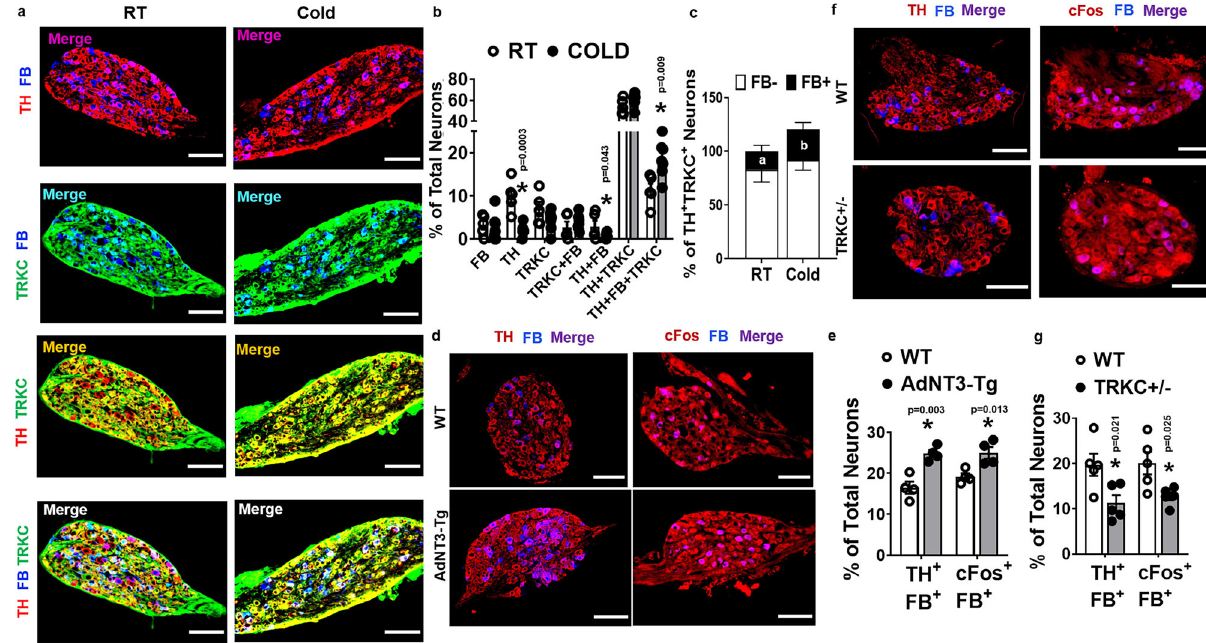
Fig. 6 NT-3/TRKC regulates sympathetic ganglia neuronal activity. a , b Representative images of TH, Fast Blue (FB) and TRKC-EYFP labeling ( a , from fi ve replicate animals for RT, and 7 replicate animals for cold, scale bar = 75 µ m), and percentage of single-, double-, and triple-labeled neurons ( b , RT = 5, cold = 7, * indicates statistical signi fi cance between RT and cold treatments with unpaired two-tailed t test) in sympathetic ganglia at thoracic T2 level in TRKC-Cre::R26EYFP mice at room temperature (RT) or subjected to a 7-day cold challenge. In panel b , the calculation of single-, double-, and triple-labeled neurons is mutually exclusive, i.e., the number of single-labeled neurons does not include double- or triple-labeled neuron numbers, and the number of double-labeled neurons does not include triple-labeled neuron numbers. c Percentage of FB-positive (FB + ) and FB-negative (FB - ) neurons in TH/TRKC- positive neurons in sympathetic ganglia at thoracic T2 level in TRKC-Cre::R26EYFP mice at room temperature (RT) or subjected to a 7-day cold challenge (RT = 5, COLD = 7, a vs b: FB + in RT vs FB + in cold, P = 0.010 with unpaired two-tailed t test). d , e Representative images ( d , from four replicate animals/ group, scale bar = 75 µ m) and quantitation ( e , n = 4/group, * indicates statistical signi fi cance between WT and AdNT3-Tg with unpaired two-tailed t test) of TH/FB and cFos/FB labeling in sympathetic ganglia at thoracic T2 level in WT and AdNT3-Tg mice after a 7-day cold challenge. f , g Representative images ( f , from fi ve replicate animals/group, scale bar = 75 µ m) and quantitation ( g , n = 5/group, * indicates statistical signi fi cance between WT and TRKC + / − with unpaired two-tailed t test) of TH/FB and cFos/FB labeling in sympathetic ganglia at thoracic T2 level in WT and TRKC + / − mice after a 7-day cold challenge. All data are expressed as mean ±